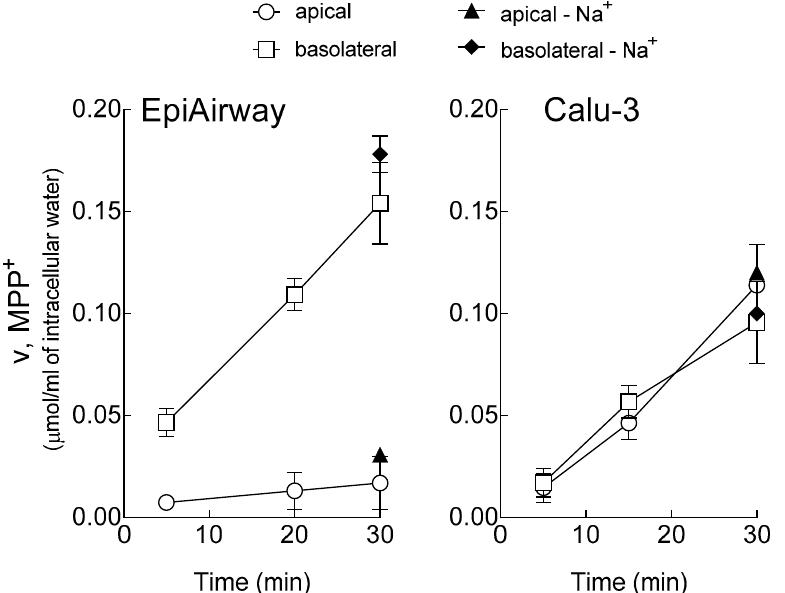
Figure 1. Time-dependent accumulation of 1-methyl-4-phenylpyridinium (MPP + ) in EpiAirway ™ and Calu-3 monolayers. Cells were washed with Earle’s Balanced Salt Solution (EBSS) or Na + -free EBSS (-Na + ) and incubated for the times indicated in the same bu ff er containing [ 3 H]MPP + (50 µ M; 2 µ Ci / mL), either added to the apical or to the basolateral compartment, as indicated. The intracellular [MPP + ] was determined as described in the Material and Methods Section. Points represent the mean ± SEM of three independent determinations.